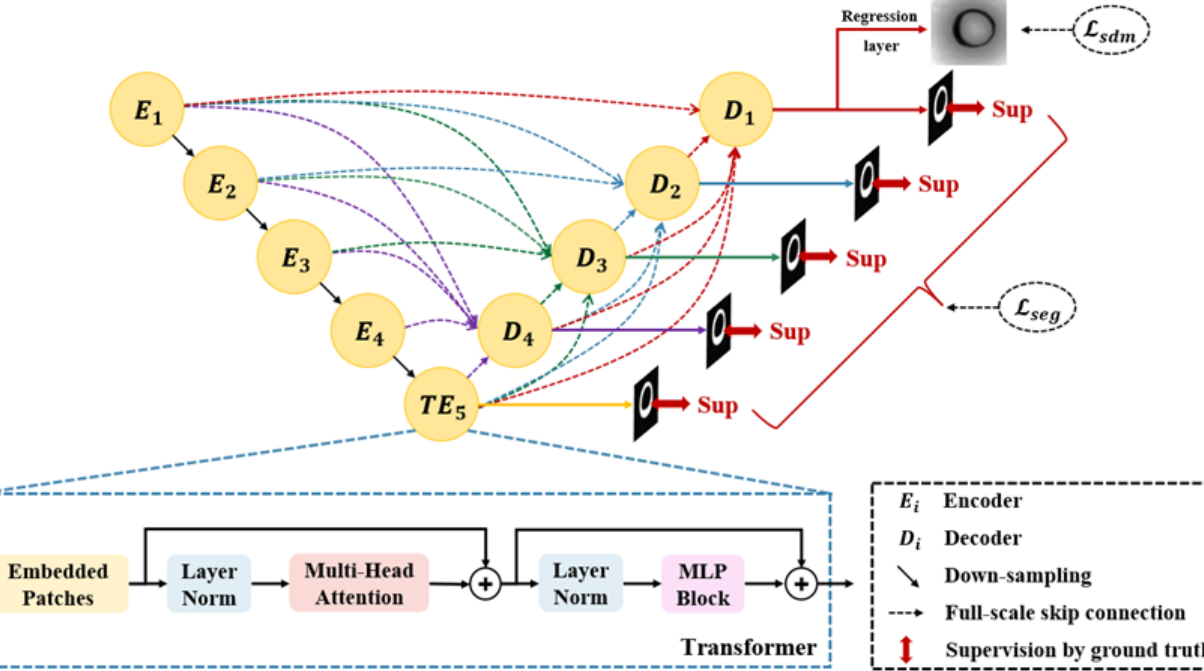
Figure 3. The proposed LV segmentation model is based on an encoder–decoder architecture. The network outputs pixel probability maps and